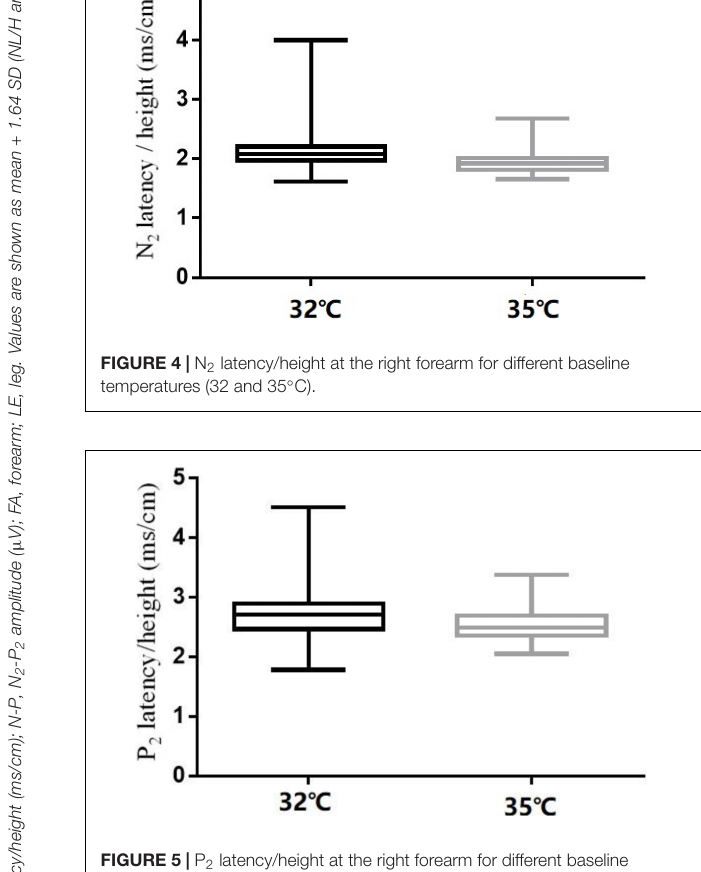
were not detectable at a lower baseline temperature (32 ◦